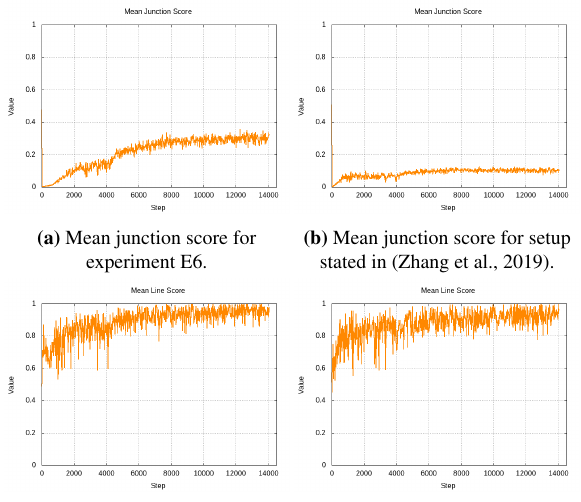
Figure 2. Graphs showing the mean line and junction score for case E6 (see Table 1) and the original setup during the training process. An exponential moving average with a smoothing factor of 0.9 was chosen to smooth the